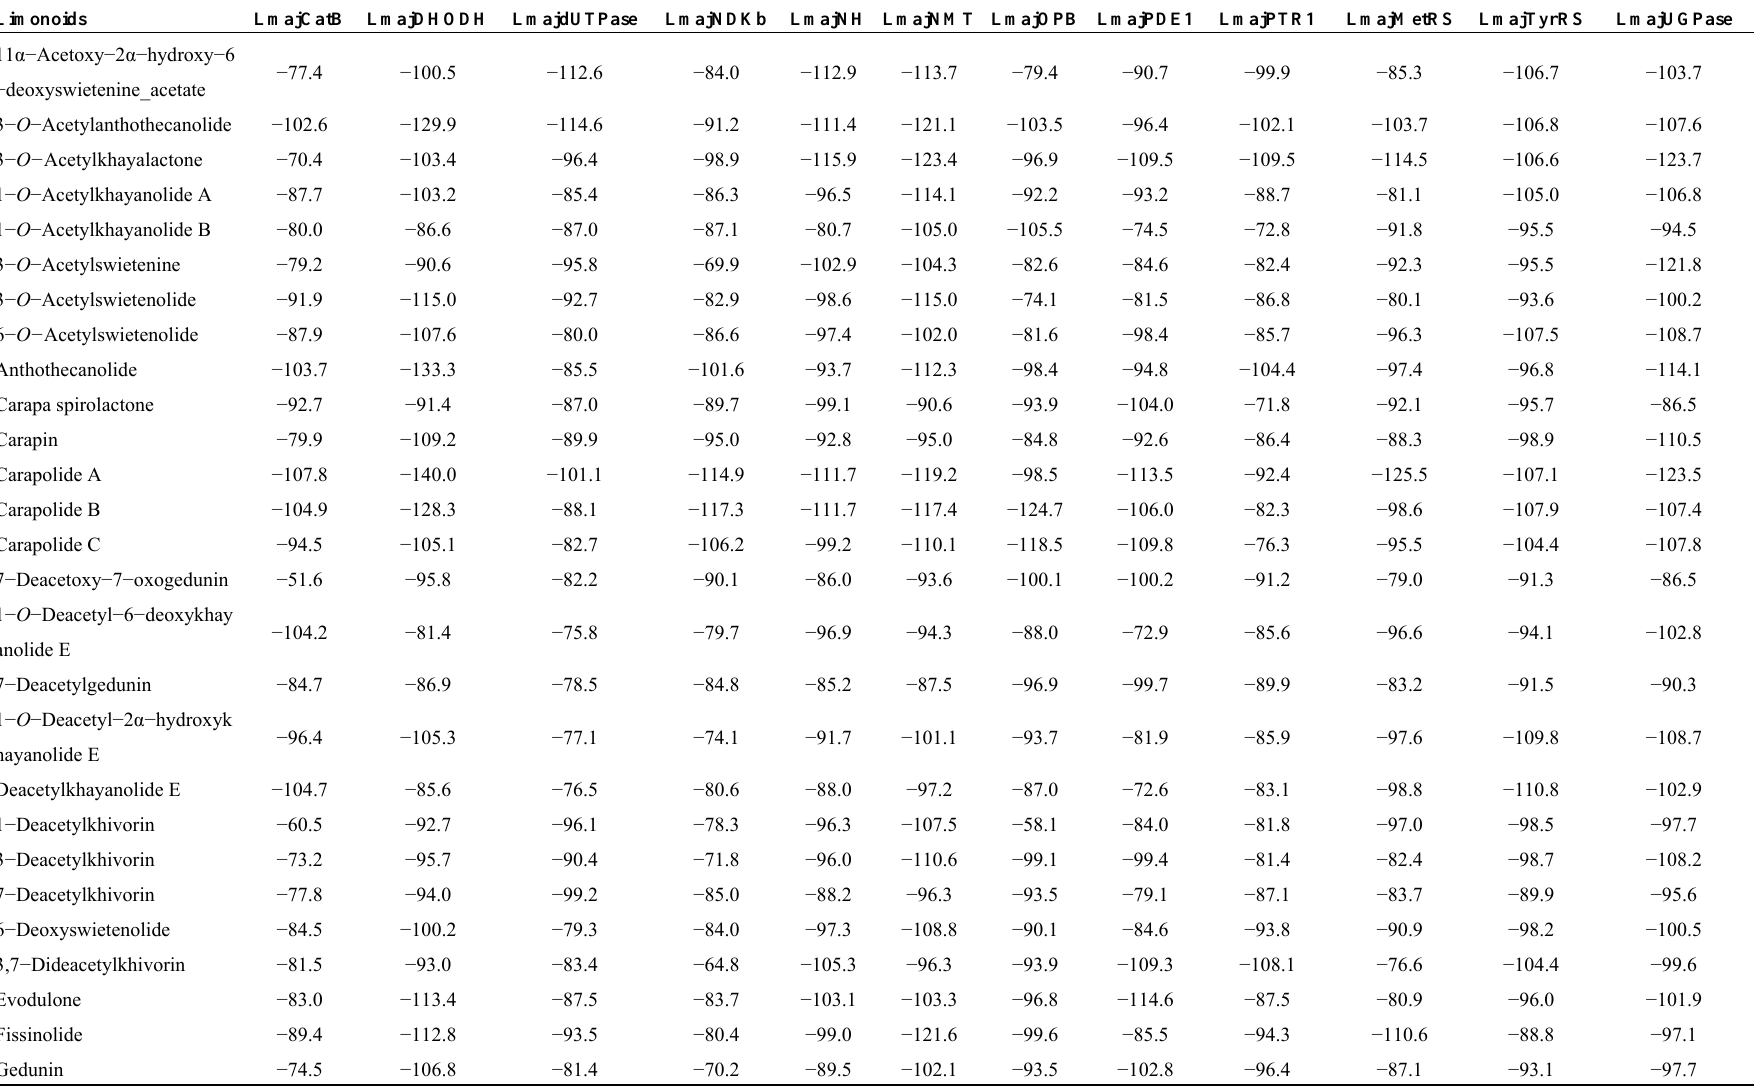
Table 29. MolDock docking energies (kJ/mol) of limonoids with Leishmania major protein